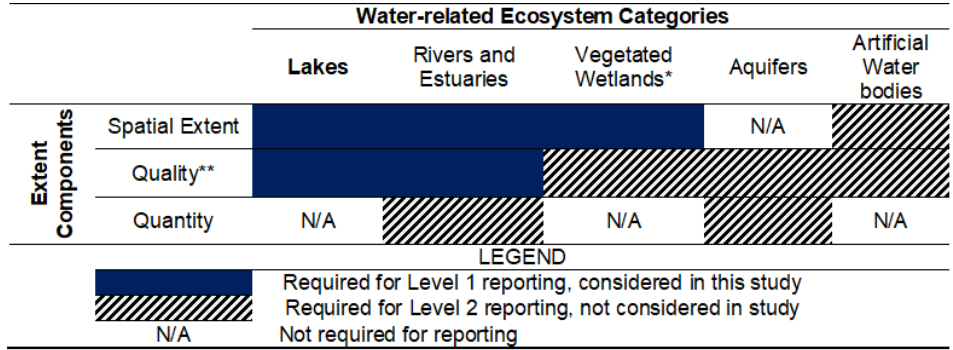
Table 1. Water-related ecosystem components and categories required for country reporting in the 2018 monitoring methodology for Sustainable Development Goal (SDG) Indicator 6.6.1 [46] with an indication of those considered in this study.